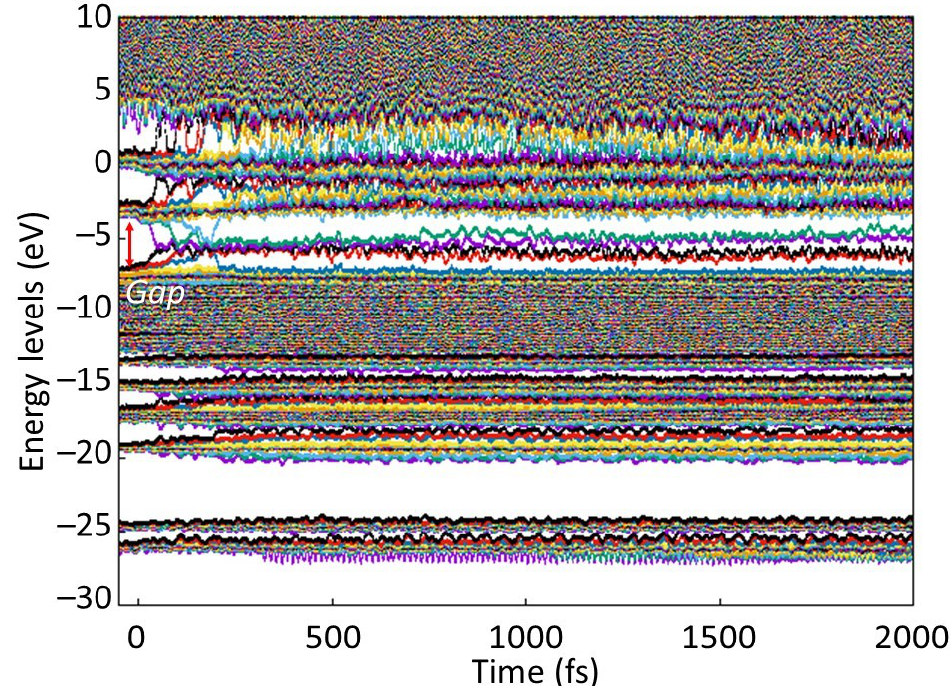
Figure 5. Evolution of the electronic energy levels (eigenstates; molecular orbitals) in PMMA irradiated with 0.1 eV/atom deposited dose. The initial HOMO-LUMO gap is marked with a red arrow.